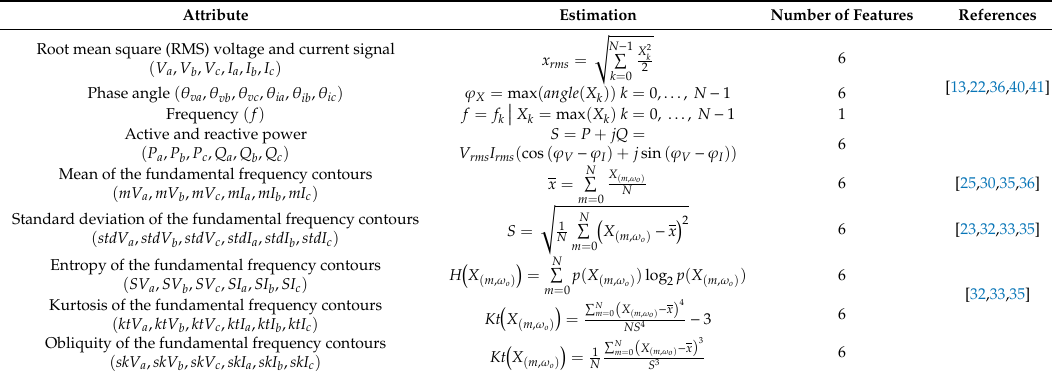
Table 3. Definition and estimation of attributes.